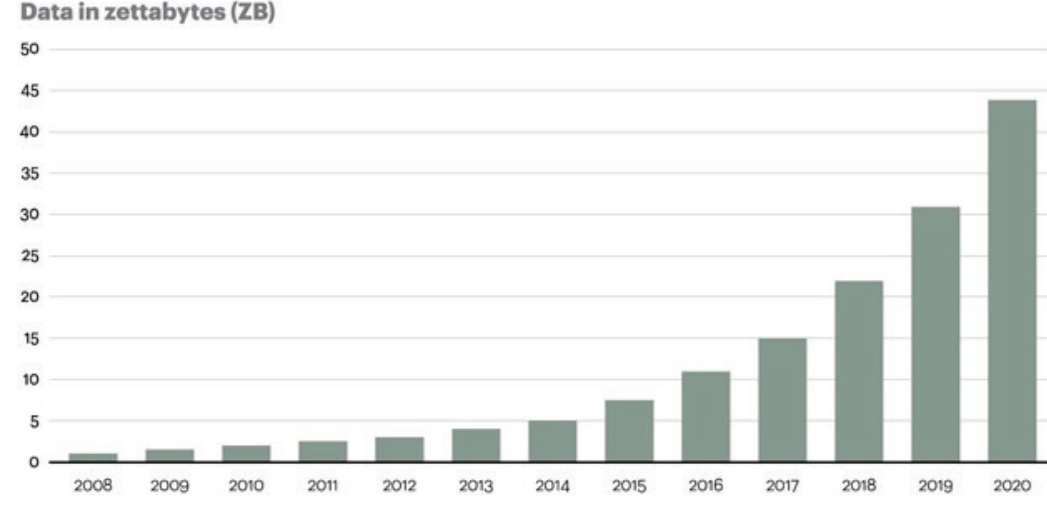
Fig. 2. Percentage data increase – Forecast until